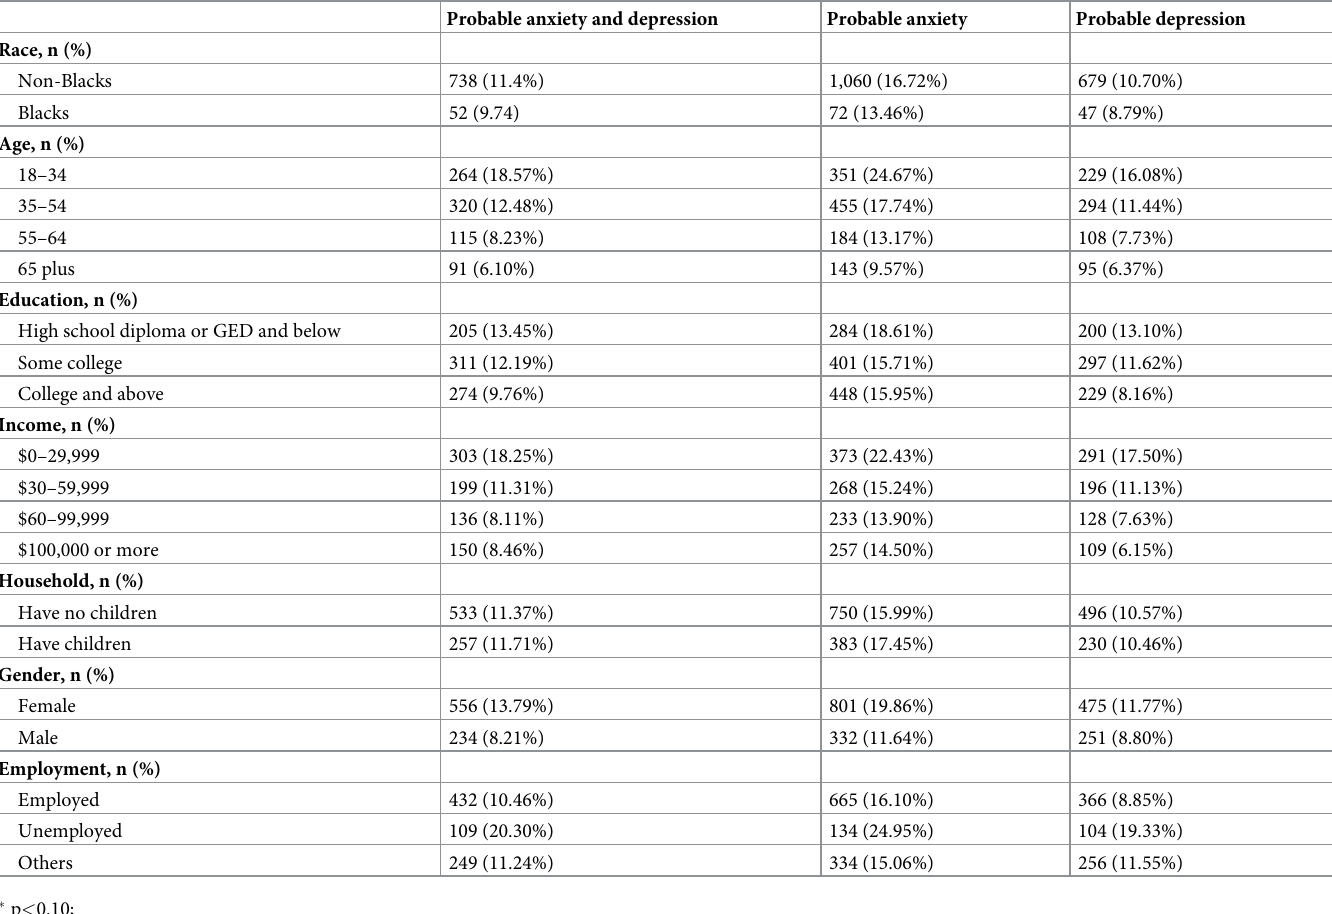
Table 3. Prevalence of reporting symptoms for anxiety and depression, anxiety, and depression across subpopulation groups in Wave